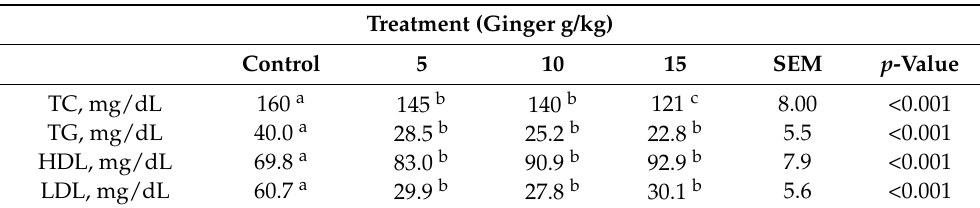
Table 8. The effects of different levels of ginger powder on blood cholesterol, triglyceride, high- and low-density lipoprotein content in broiler